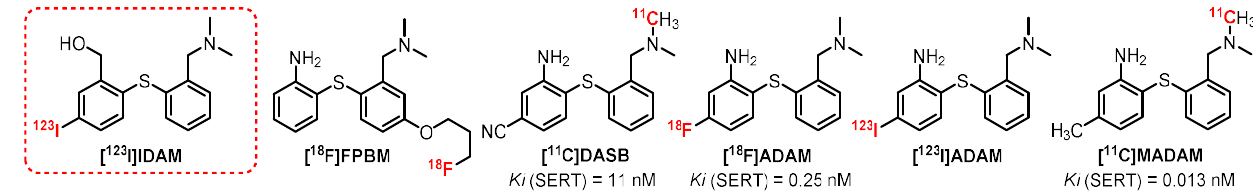
Figure 22. [ 123 I]IDAM derivatives.